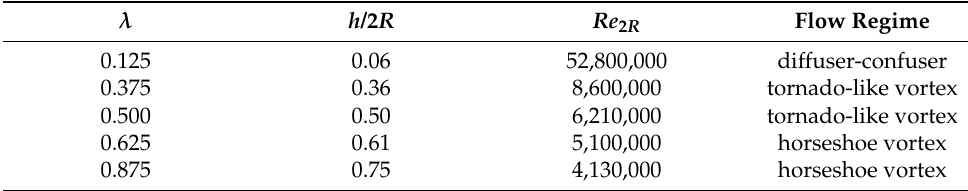
Table 4. Flow regime corresponding the parameter of